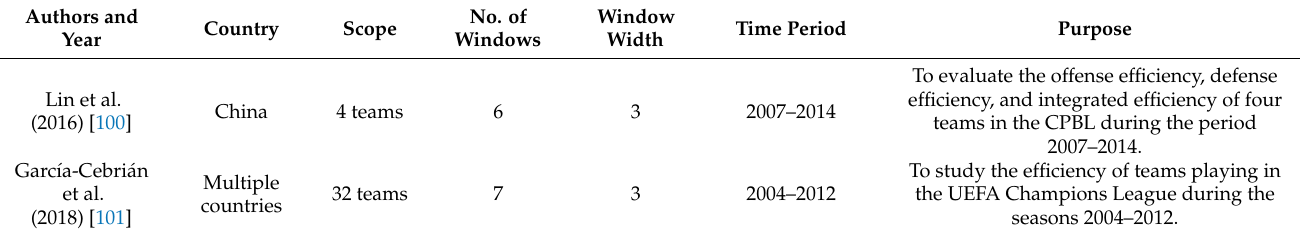
Table 14. Articles classified under the sport